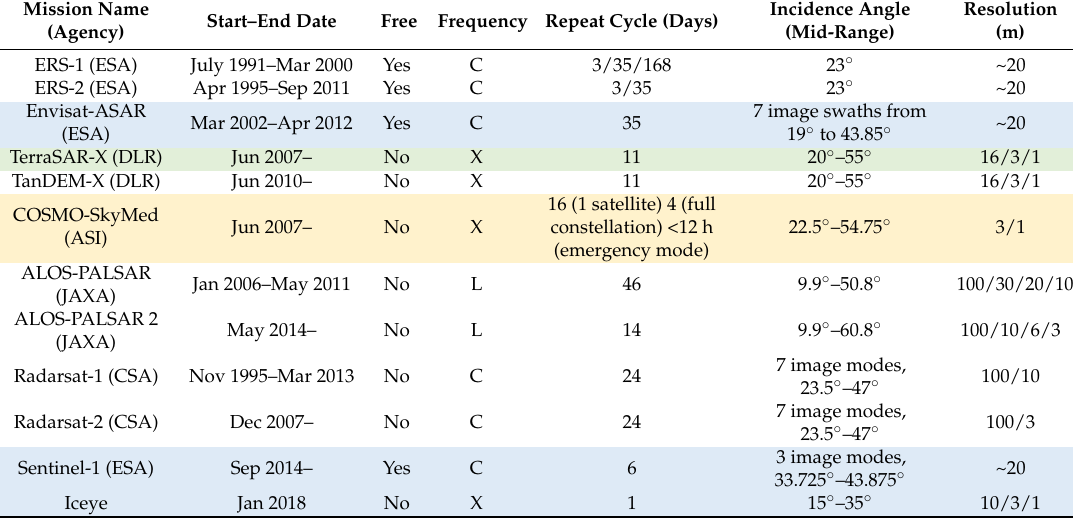
Table 2. Synthetic aperture radar (SAR) missions overview. Envisat-ASAR and Sentinel-1 (highlighted in blue) were considered for all case studies. TerraSAR-X, highlighted in green, was considered only for Lagos, Nigeria and COSMO-SkyMed, highlighted in yellow, for Banjul, the Gambia. ESA, European Space Agency; ASAR, advanced synthetic aperture radar; DLR, German Aerospace Center; ASI, Italian Space Agency; ALOS-PALSAR, Advanced Land Observation Satellite phased array type L-band synthetic aperture radar; JAXA, Japanese Aerospace Exploration Agency; CSA, Canadian Space